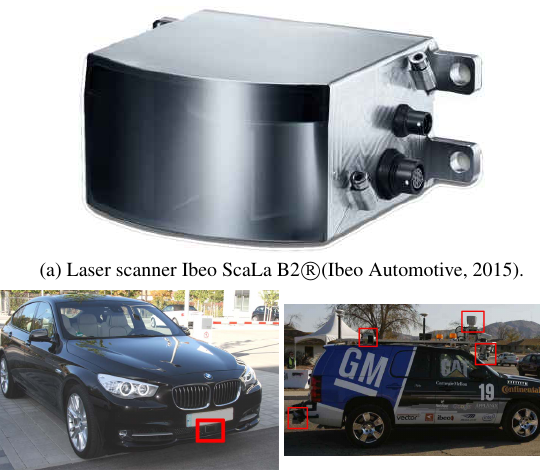
Figure 1: Automotive laser